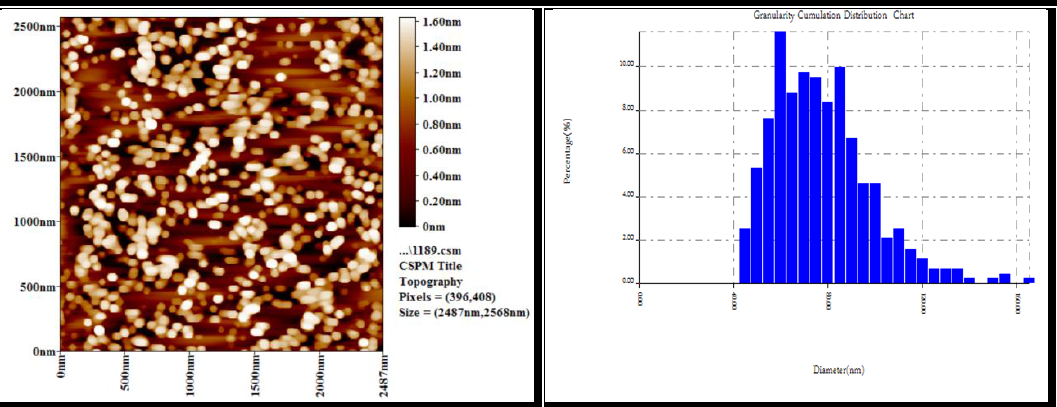
Fig. 6: Surface roughness and histogram of Cr-doped TiO